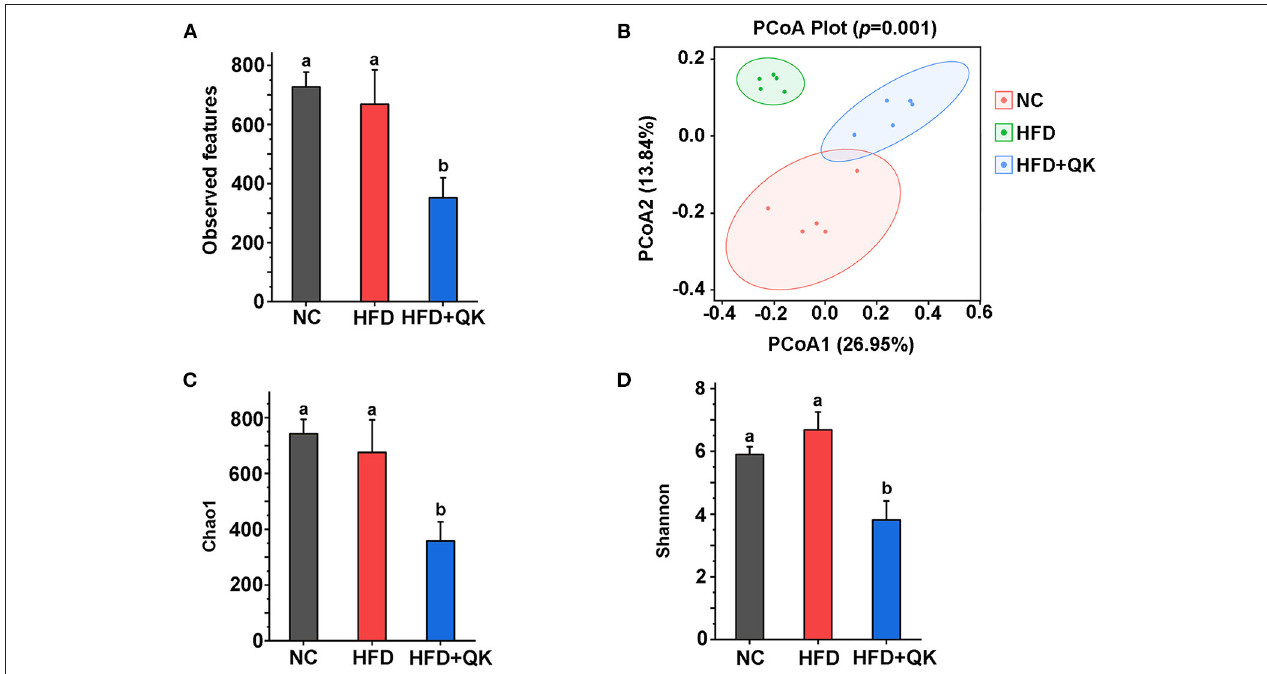
FIGURE 3 | Effect of WGQK on α -diversity and β -diversity of gut microbiota in mice. (A) Average observed feature numbers of each group’s mice; (B) Principal coordinates analysis score plot (PCoA) of gut microbiota among three groups; (C,D) Two index of α -diversity analysis, (C) Chao1 and (D) Shannon of three groups. Data are presented as mean ± SD ( n = 5), significant difference was determined using an unpaired two-tailed t -test, different superscript letters of any two means represent significant differences ( p < 0.05).